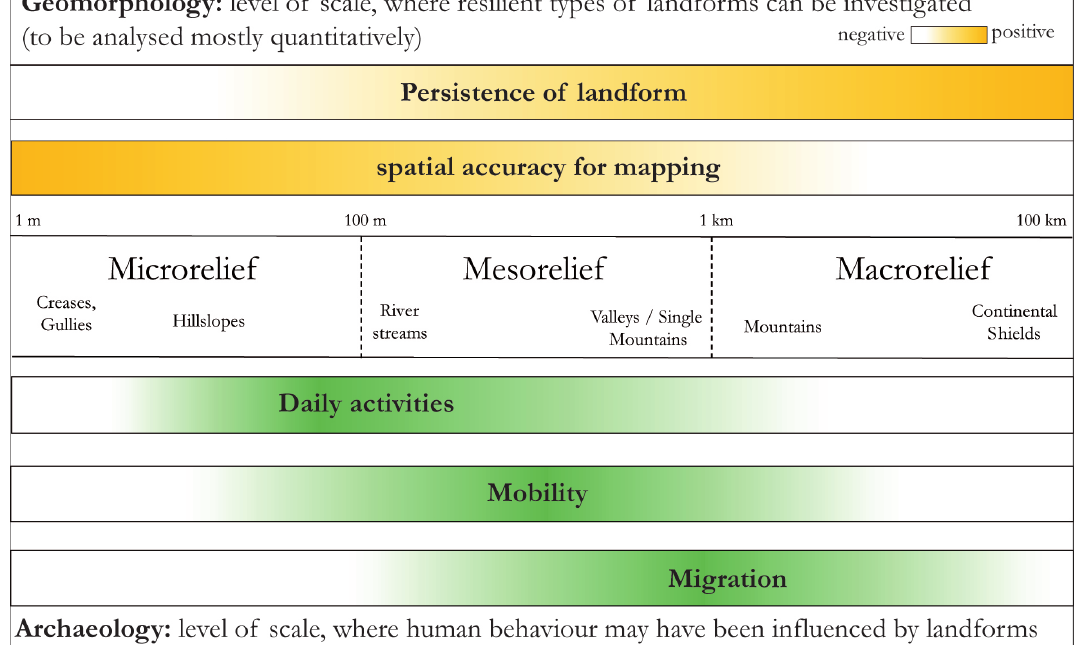
Figure 7. Synthesis of spatial scales based on geomorphological relief units and their link to human behavior as classification in geomorphometric analysis in Paleo-GIS Applications, source [43]. 2.1.7. Oscillayers: A Dataset for the Study of Climatic Oscillations over Plio-Pleistocene Time-Scales